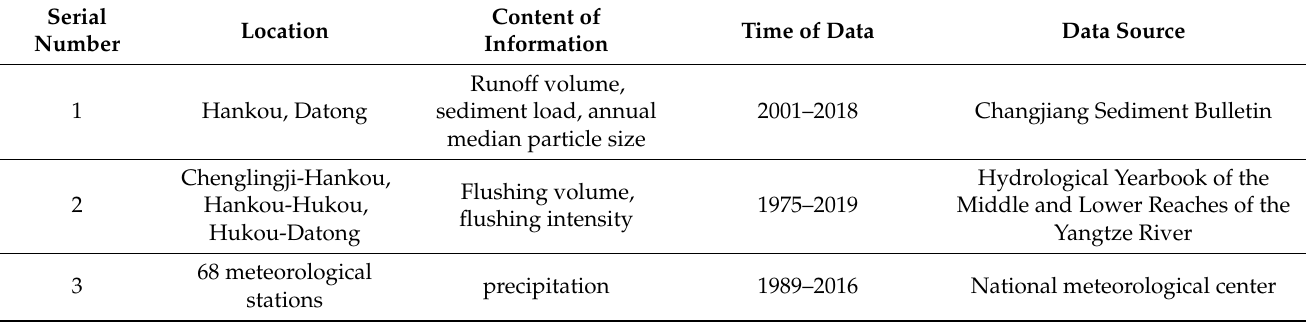
Table 2. Hydrological observation data from the Chenglingji to Datong